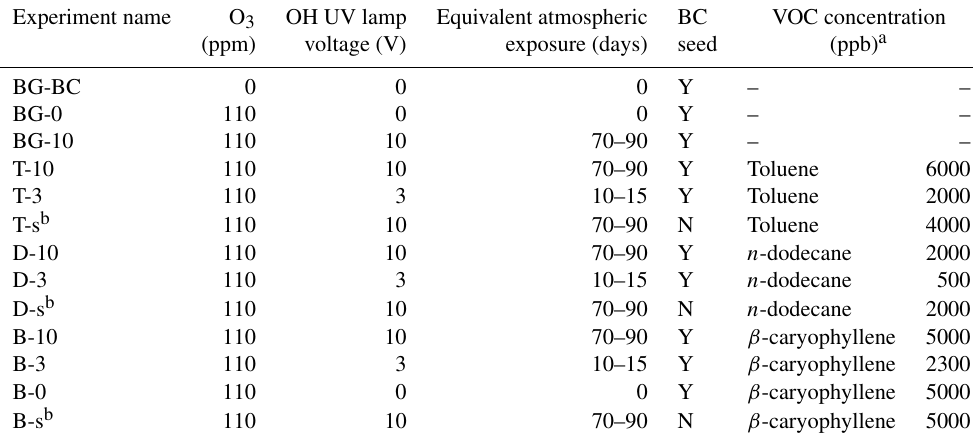
Table 2. Experiment conditions of BC and SOA coating experiments. The name prefixes BG, T, D, and B stand for background test, toluene SOA coating experiments, n -dodecane SOA coating experiments, and β -caryophyllene SOA coating experiments, respectively. The name suffixes BC, 0, 3, 10, and s denote seed BC only, O 3 oxidation only, low OH exposure level, high OH exposure level and SOA self-nucleation experiments, respectively. Note: ppb – parts per billion; ppm – parts per